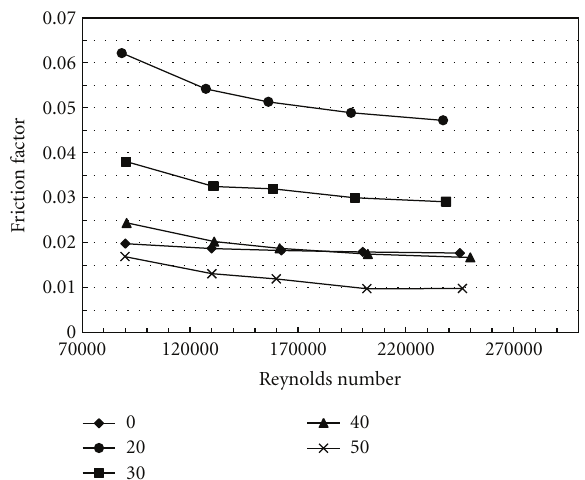
Figure 7: Friction factor for helically grooved stators at 4000 rpm versus Re.